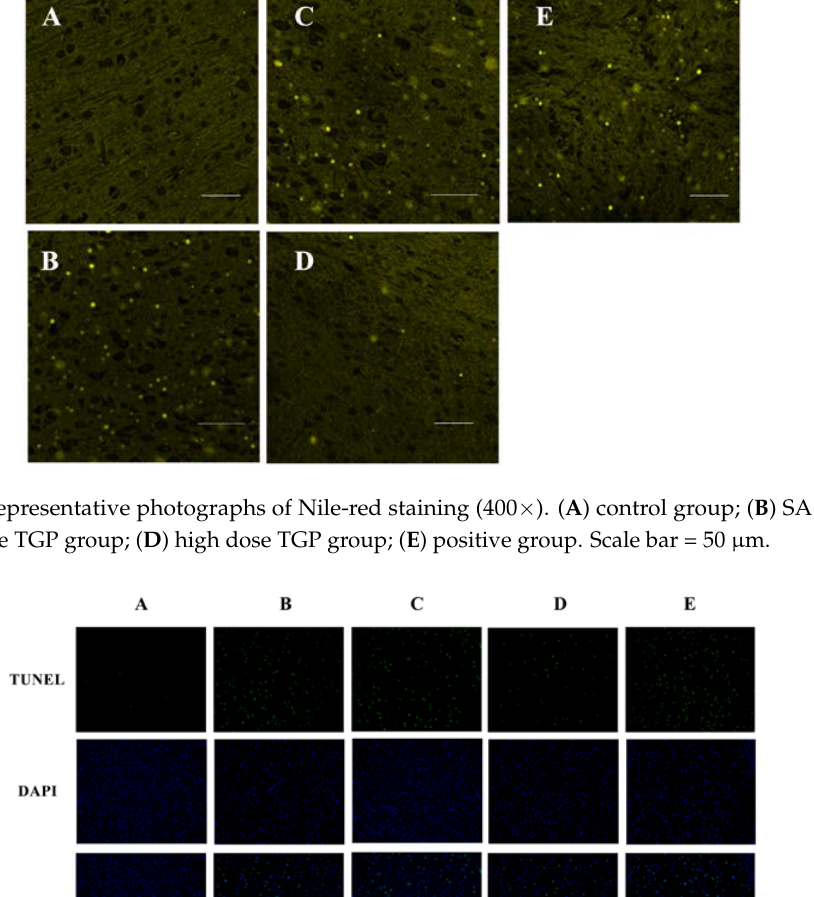
Figure 3. Representative histopathological photographs of rat cerebral cortexes (20×): ( A ) control group; ( B ) SA group; ( C ) low dose TGP group; ( D ) high dose TGP group; ( E ) positive group. The black arrow, liquefactive necrosis; red arrows, glial cells; blue circles, neuronophagia. Scale bar = 50 μm.